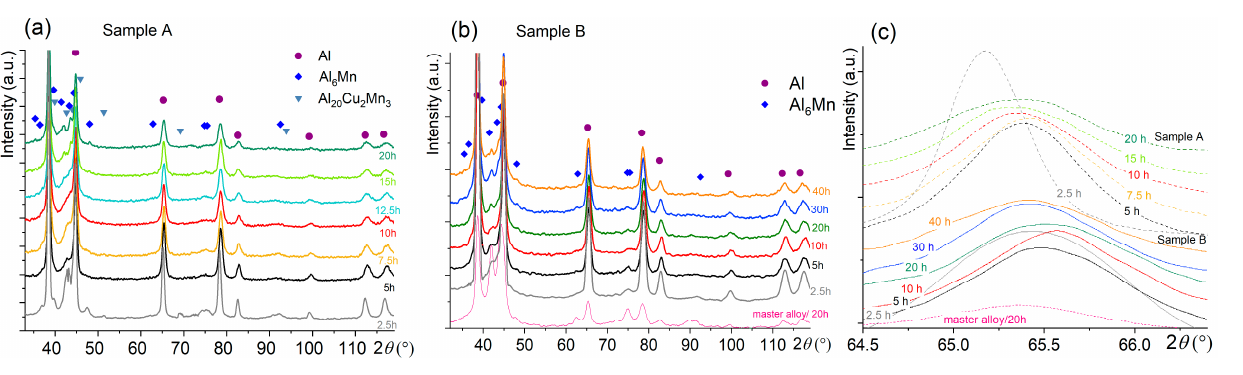
Figure 4. Evolution of ( a , b ) the XRD pattern and ( c ) the Al solid solution peak of ( a ) sample A and